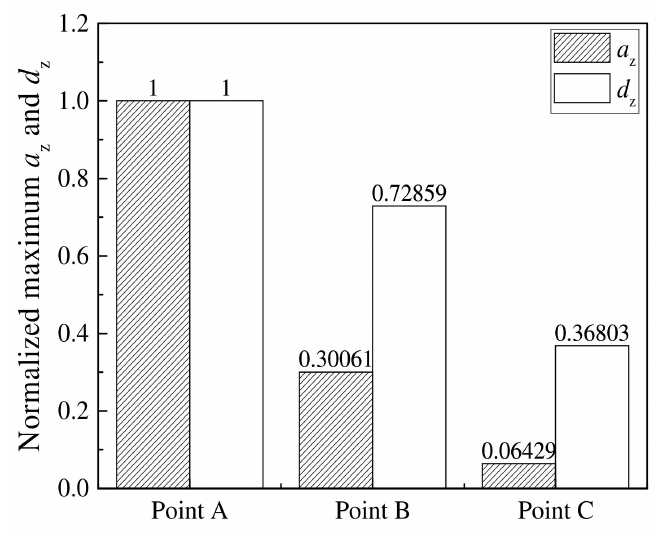
Figure 8. Comparisons of normalized maximum a z and d z at different points.